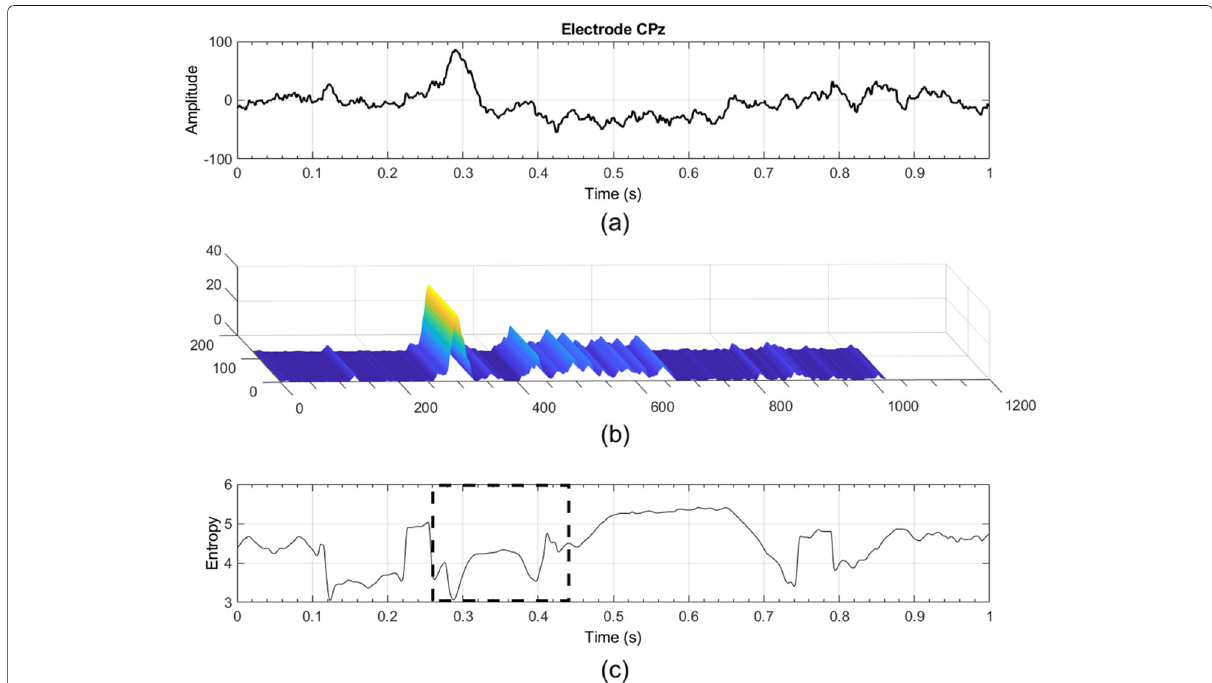
Fig. 15 Electrode CPz after RICI. a Time domain representation of ERP. b SPWVD time-frequency representation. c Short-term Rényi entropy of the distribution